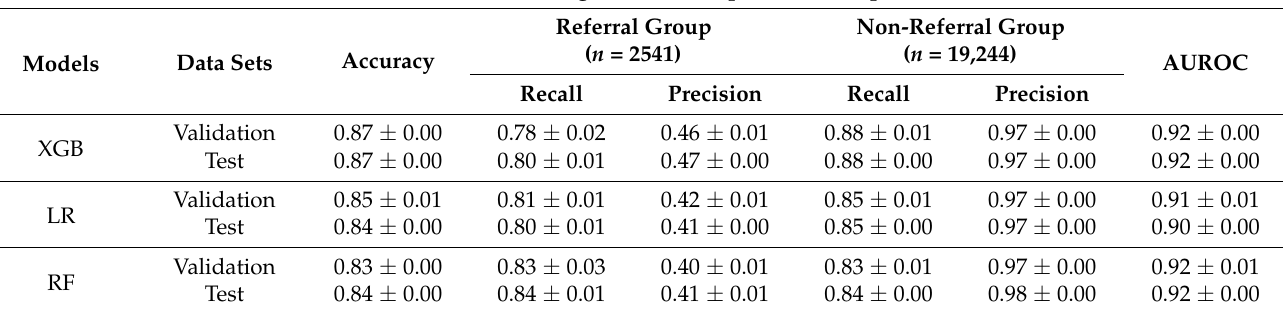
Table 5. Performance metrics for the three models with loose inclusion and labeling criteria compared with experiment 1 and experiment